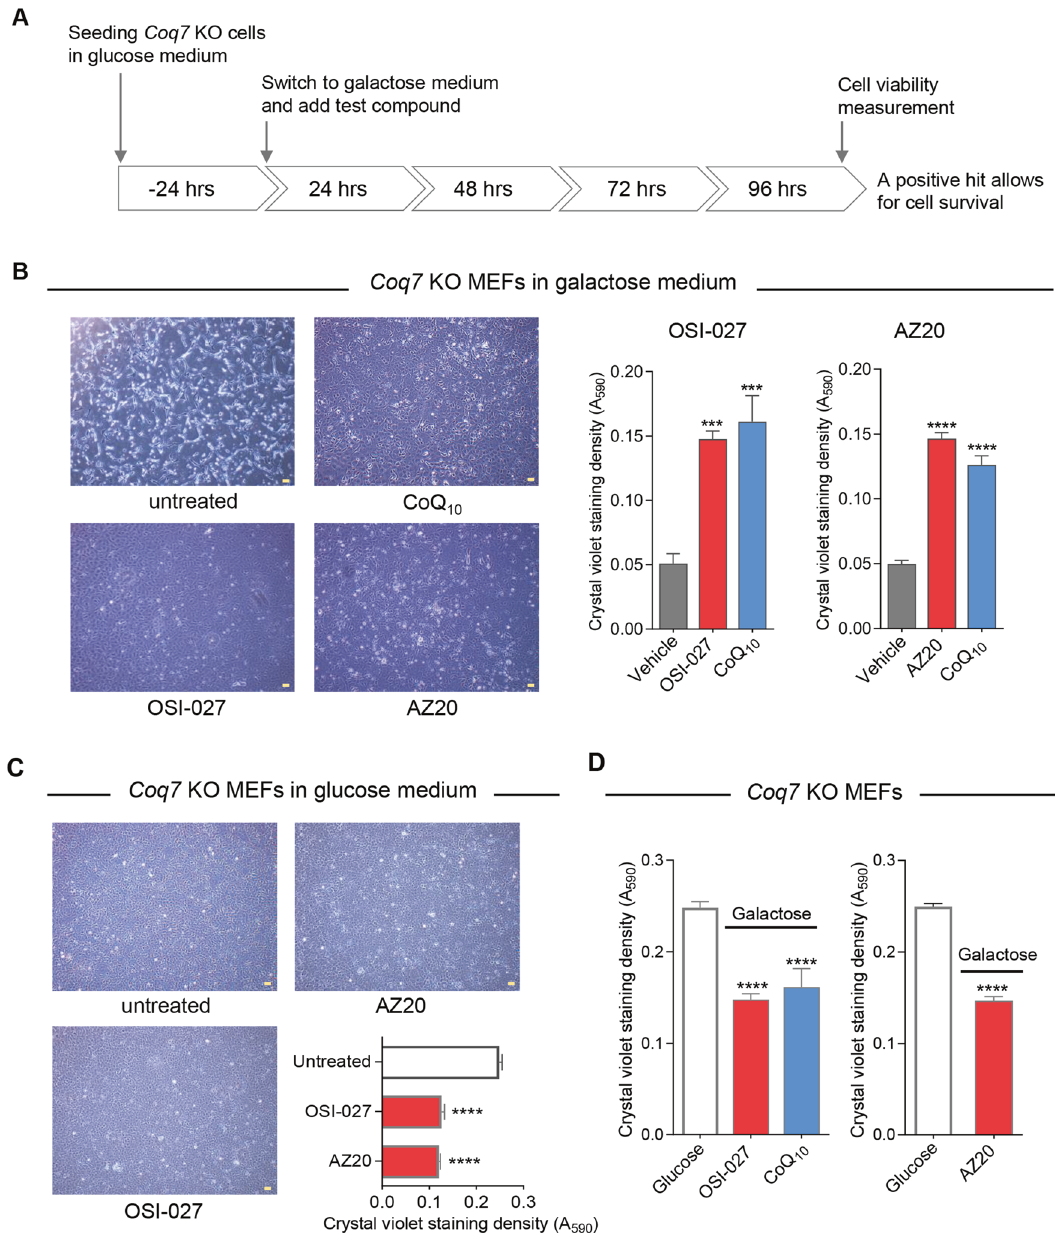
Fig. 1 Identi fi cation of compounds that enhance the survival of Coq7 KO cells in galactose medium. A Screening strategy. Primary screening of compound library was conducted with Coq7 KO mouse embryonic fi broblasts (MEFs) and test compounds that increase the survival of Coq7 KO cells in galactose medium were identi fi ed as screen hits. B OSI-027 and AZ20, two of the compounds identi fi ed in the screen, showed a positive effect on the survival of Coq7 KO cells in galactose medium. Cell viability was examined after 4-day culture in galactose medium. Phase-contrast microscopy images are shown on the left, and cell growth and survival measured by using the Crystal violet (CV) staining assay is on the right. DMSO is the vehicle control. C OSI-027 and AZ20 treatments cause no cell death but decrease CV staining. D OSI-027 or AZ20-treated Coq7 KO cells in galactose showed a lower CV staining intensity compared with the cells grown in glucose medium. The following doses were used in all experiments unless otherwise stated: OSI-027: 5 µM, AZ20: 10 µM, and CoQ 10 : 10 µM, which was used as a positive treatment control. Scale bars = 100 µm. Data are presented as means ± SEM for n = 4 – 8. *** p < 0.001 and **** p < 0.0001, assessed by one-way ANOVA followed by Dunnett ’ s multiple comparison test or t -test versus the untreated or glucose-grown